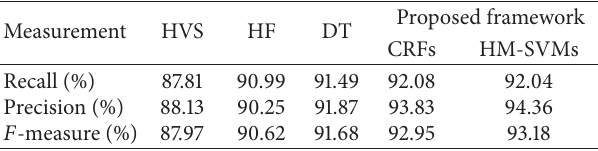
Figure 3: Performance for CRFs and HM-SVMs at each iteration. Table 3: Performance comparison between the proposed frame- work and threeother approaches (HF denotes the hybrid framework and DT denotes discriminative training the HVS